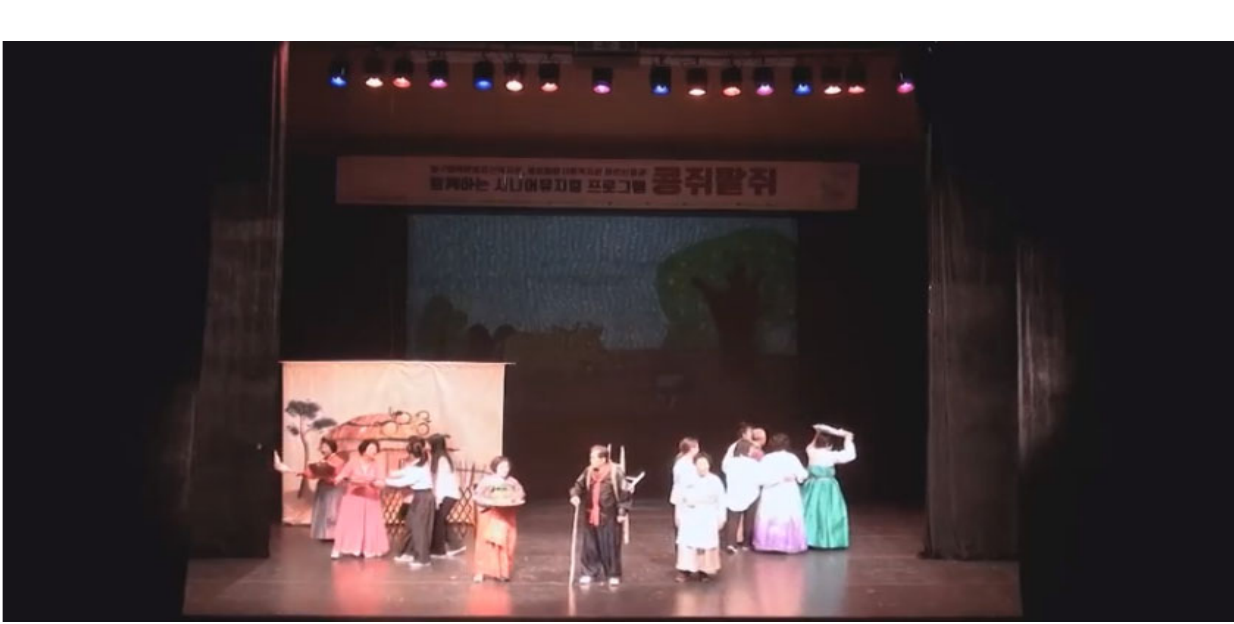
Figure 1. Senior musical program.